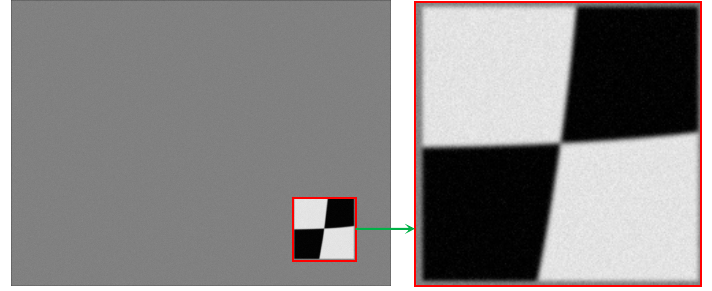
Figure 8. Chessboard image captured by simulation with the first order radial distortion, k 1 = − 5.